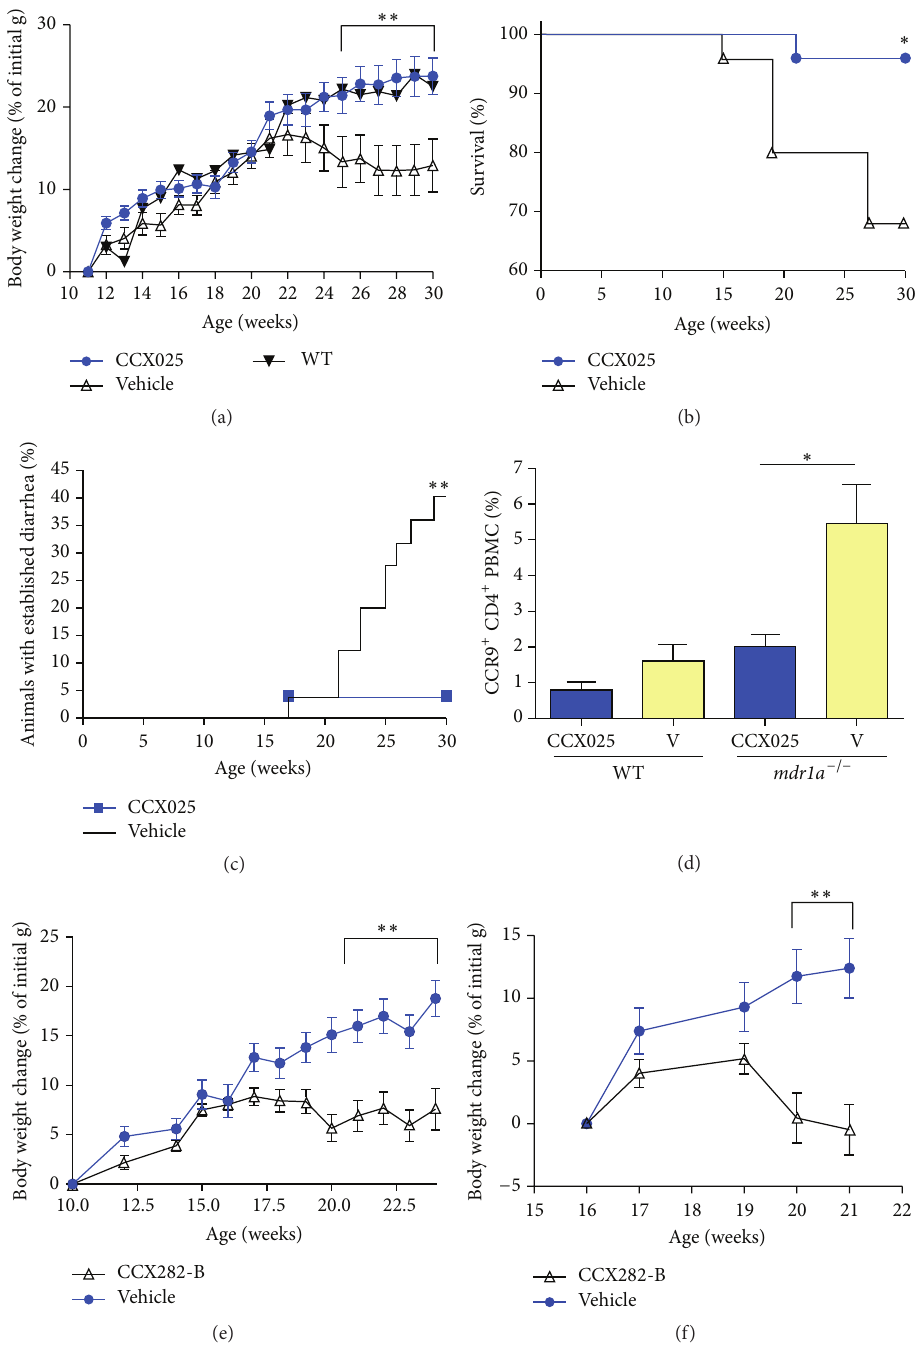
Figure 4: Pharmacological CCR9 inhibition results in a significant reduction in severity of colitis symptoms in mdr1 −/− mice. (a) CCX025 treatment, starting at 11 weeks of age, resulted in a significant inhibition of the growth retardation associated with disease. Mice treated with CCX025 ( 𝑛 = 25 ) gained weight in an identical fashion to wild-type controls ( 𝑛 = 5 ); vehicle-treated mdr1a −/− mice ( 𝑛 = 25 ) failed to gain weight after week 22. (b) CCX025 treatment resulted in a significant reduction in mortality compared to vehicle in mdr1a −/− mice. (c) CCX025 treatment resulted in a significant reduction in the percentage of mdr1a −/− mice that developed established diarrhea (score of ≥ 3 out of 5). (d) CCX025 treatment resulted in a significant inhibition of the disease-induced increase in CCR9 + CD4 + PBMC frequencies in mdr1a −/− mice, measured at 17 weeks of age. (e) CCX282-B treatment ( 𝑛 = 34 ), starting at 10 weeks of age, resulted in a significant inhibition of the growth retardation associated with disease, compared to controls ( 𝑛 = 29 ). (f) Therapeutic treatment with CCX282-B ( 𝑛 = 17 per treatment group) resulted in a significant reduction in the weight loss associated with active disease. Animals were randomized at 16 weeks of age to either CCX282-B or vehicle treatment. All panels: ∗ 𝑃 < 0.05; ∗∗ 𝑃 <